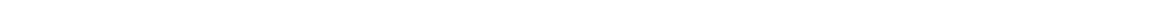
FIGURE 1 | all at once (left) or as a series of 0.5 µl droplets (right) . Adapted from [42] with permission from the Royal Society of Chemistry. (L) Simpli fi ed Te fl on-silicon chip where chip is rotated under dispensers to deliver reagents on demand. (M) Cerenkov images of chip after collection of crude product showing how the reagent delivery at excessive pressure has caused splashing (left) that is not evident at lower delivery pressure (right) . (L,M) adapted from [43] with permission from the Royal Society of Chemistry. (N) High-throughput chip containing 4 × 4 array of reaction sites. (O) Cerenkov images after a cross-contamination study (left) and after the collection step after performing 8 reactions under one set of reaction conditions and another 8 reactions under different conditions (right) . (N,O) adapted from [44] with permission from the Royal Society of Chemistry.